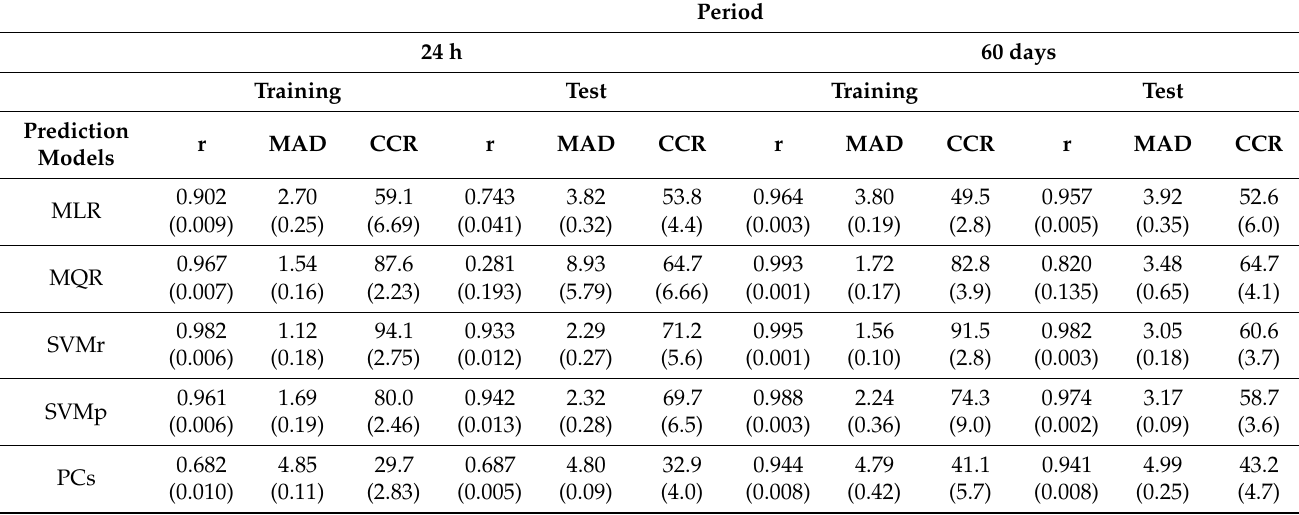
Note: performances are reported as the average and standard deviation over the five different random